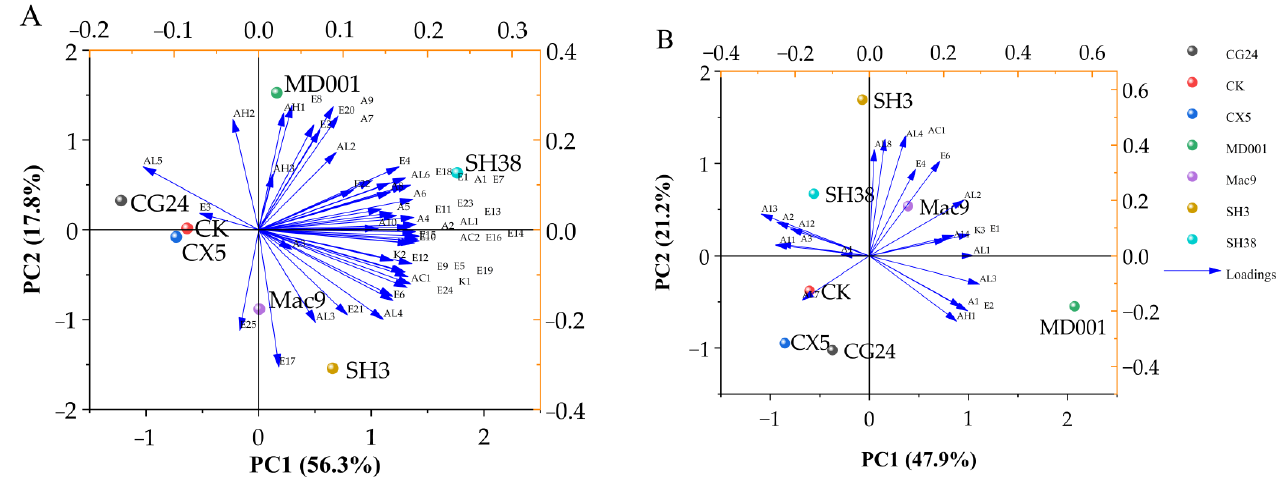
Figure 3. PCA of aroma components of ‘Huahong’ apples: score plot and loading plot of aroma components in ( A ) skin and ( B ) pulp.